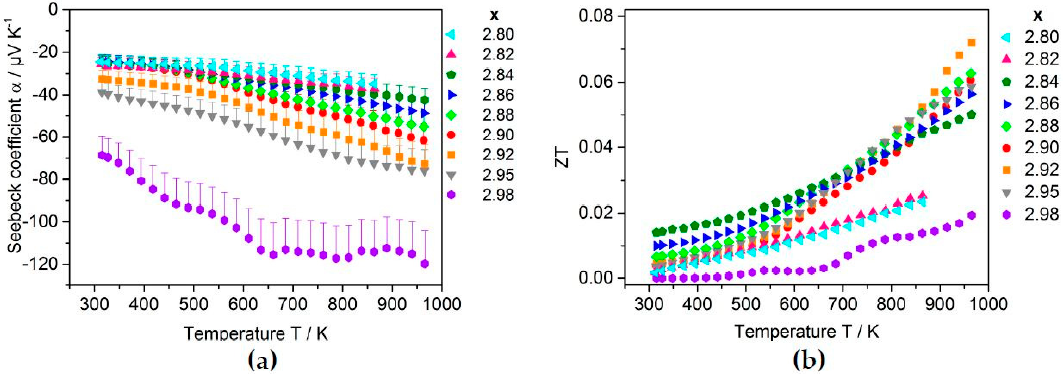
Figure 9. Thermoelectric properties of the WO x samples (2.80 ≤ x ≤ 2.98): ( a ) Seebeck coefficient α ( T ) and ( b ) resulting figures of merit ZT . Error of α ( T ) is asymmetric.